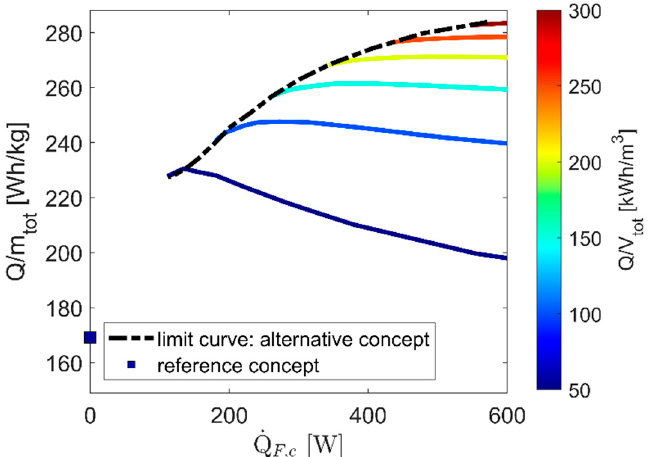
Figure 8. Systemic storage densities of the reference and the alternative concept as a function of the resulting thermal cooling powers ( 𝑄(cid:4662) (cid:3007),(cid:3030) ).